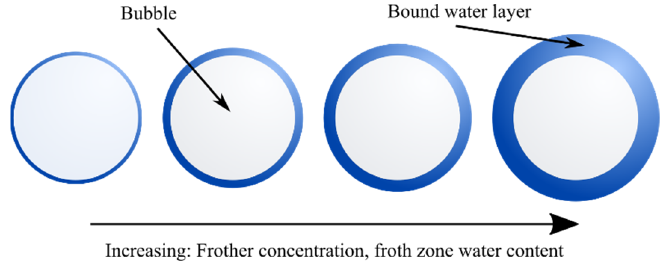
Figure 10. Proposed increase in bound water layer with increasing frother concentration.